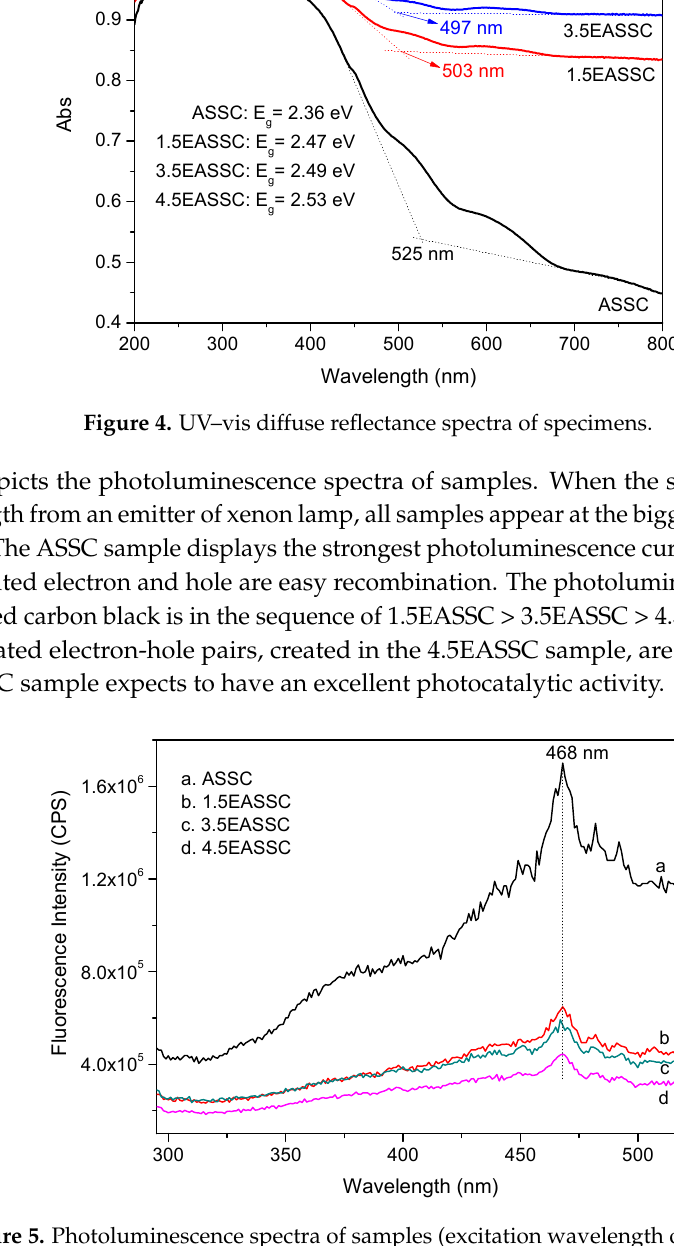
Figure 5. Photoluminescence spectra of samples (excitation wavelength of 280 nm).